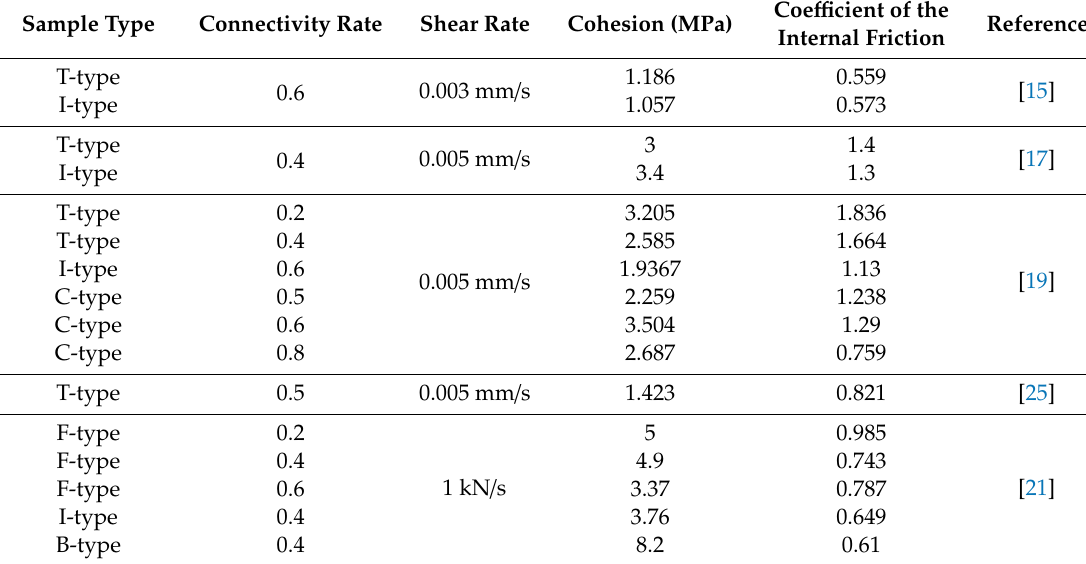
Table 2. Direct shear test results of artificial rock mass samples with various discontinuity positions and connectivity